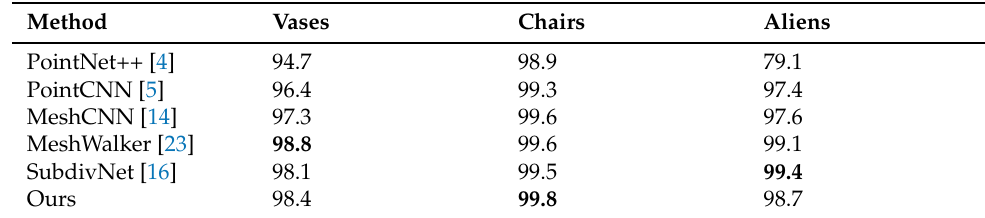
Table 3. Segmentation results on COSEG with edges labels.